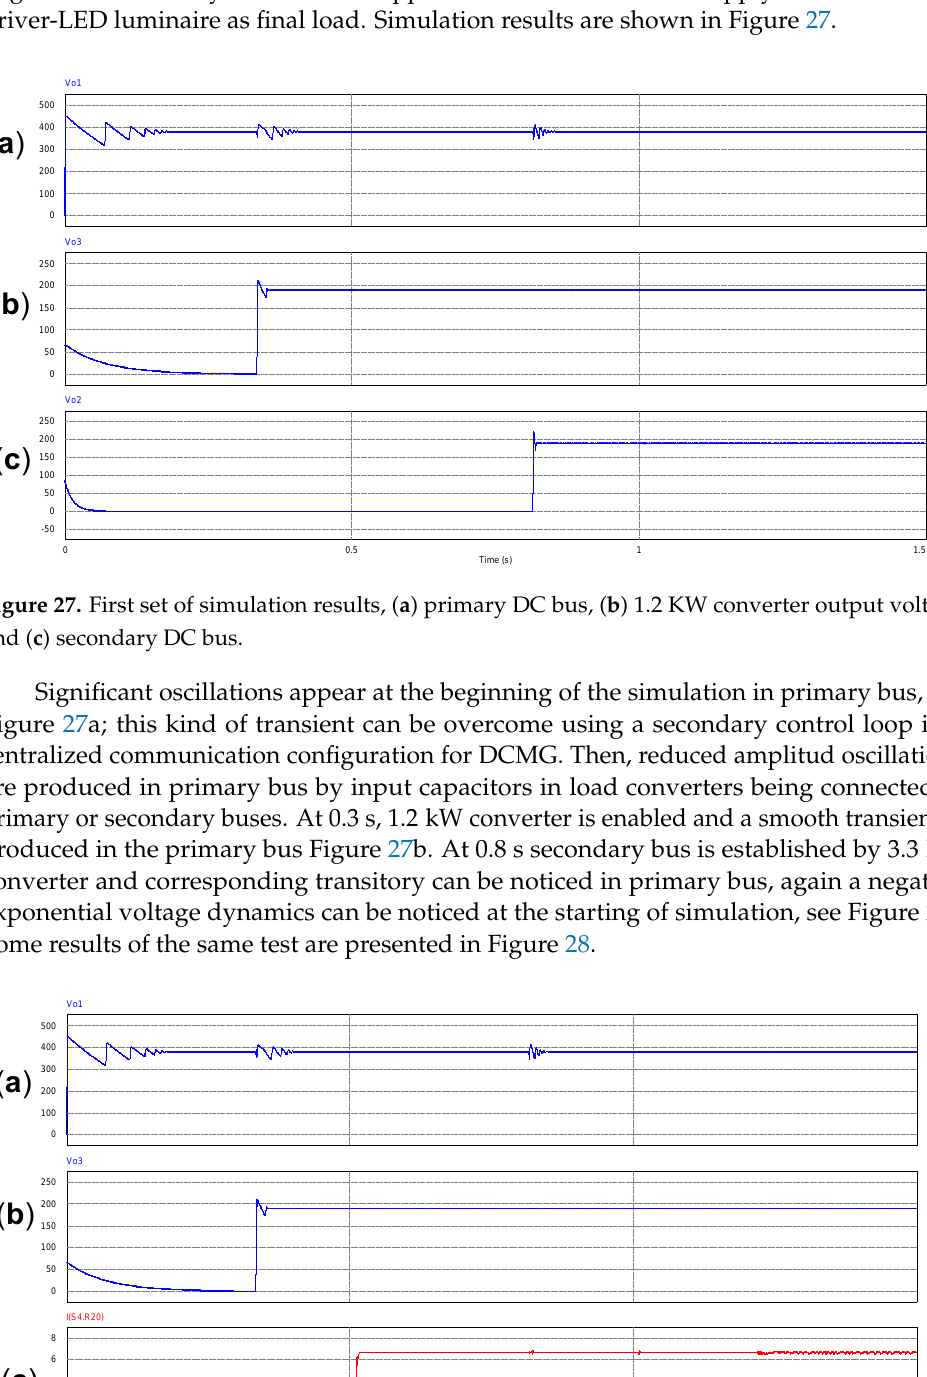
Figure 28. Second set of simulation results, ( a ) primary DC bus, ( b ) 1.2 kW converter output voltage and ( c ) electronic load input current.